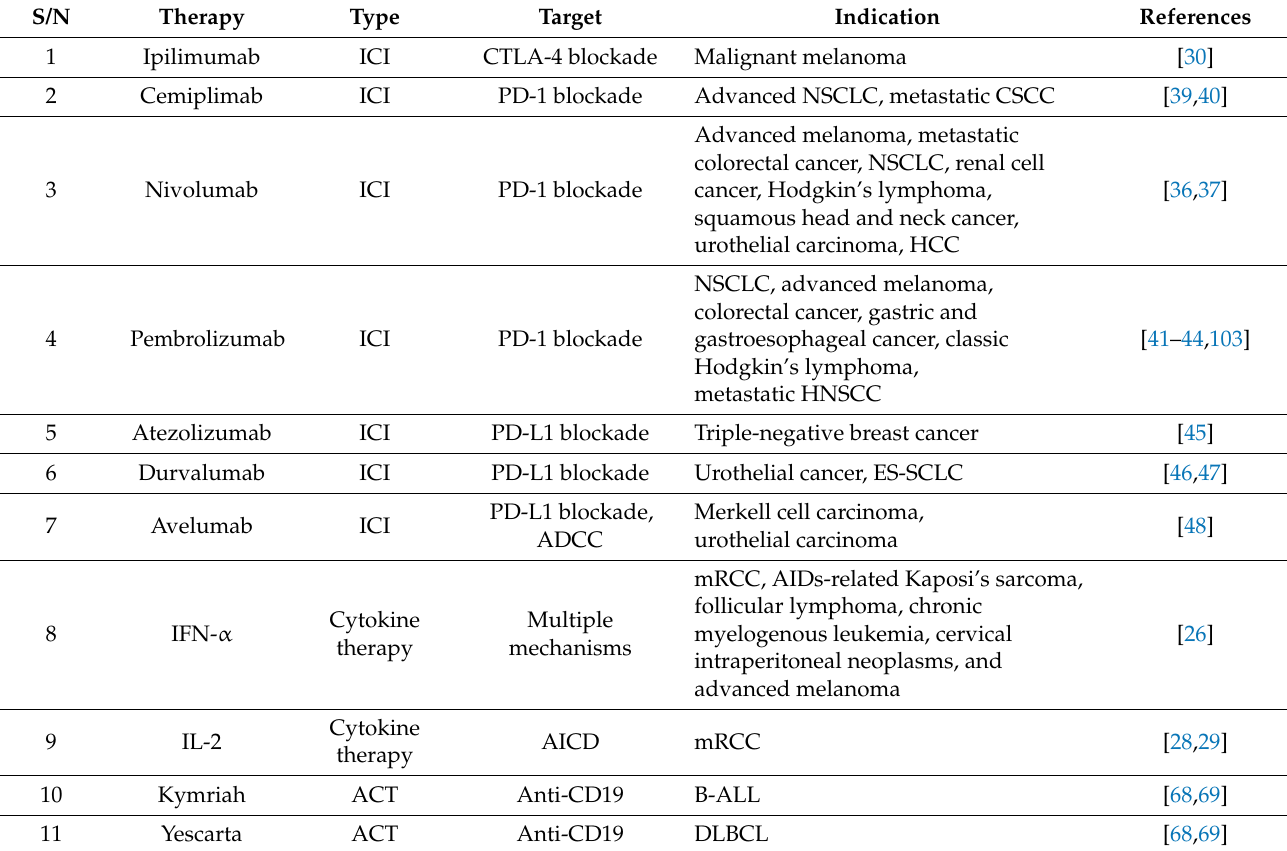
Table 1. Some examples of FDA-approved